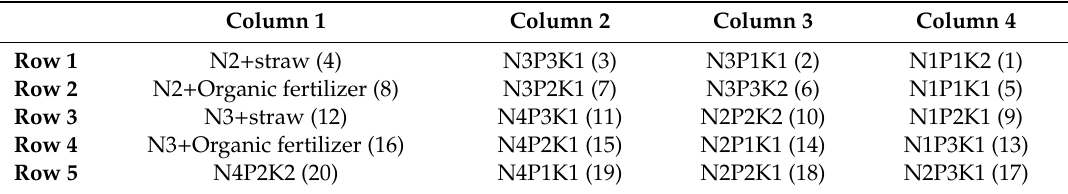
Table A1. The spatial distribution of fertilizer at 20 plots during the growth of maize. The NPK meant di ff erent combinations of fertilizers, and N represented the nitrogenous fertilizer, P represented the phosphate fertilizer, K represented the potassium fertilizer, respectively. The number after NPK represents the actual multiple of fertilizer fertilizers, and the numbers in brackets were the number of plots in corresponding with the plots shown in Figure A1.